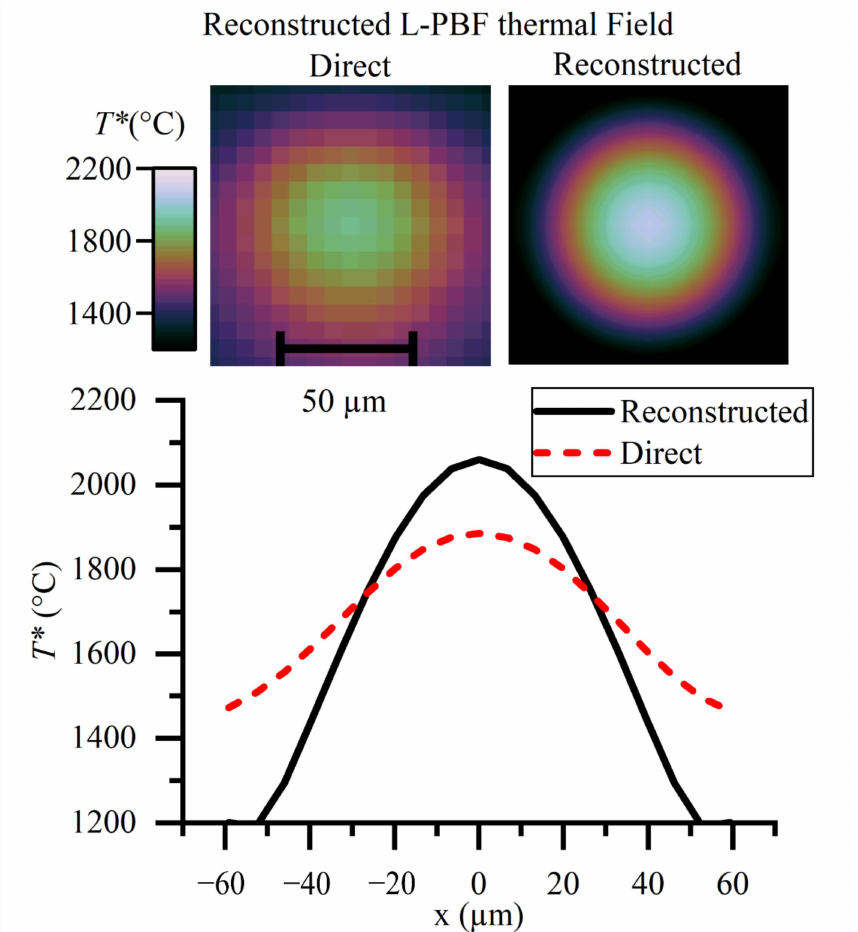
Figure 13. Reconstructed thermal field of the heat affected zone in laser-based powder bed fusion. The direct measure is made by conversion of the discrete pixel values to temperature. The reconstructed thermal field takes into account the spatial transfer function of the instrument. This work has shown the direct method to have a significant error for the length scales